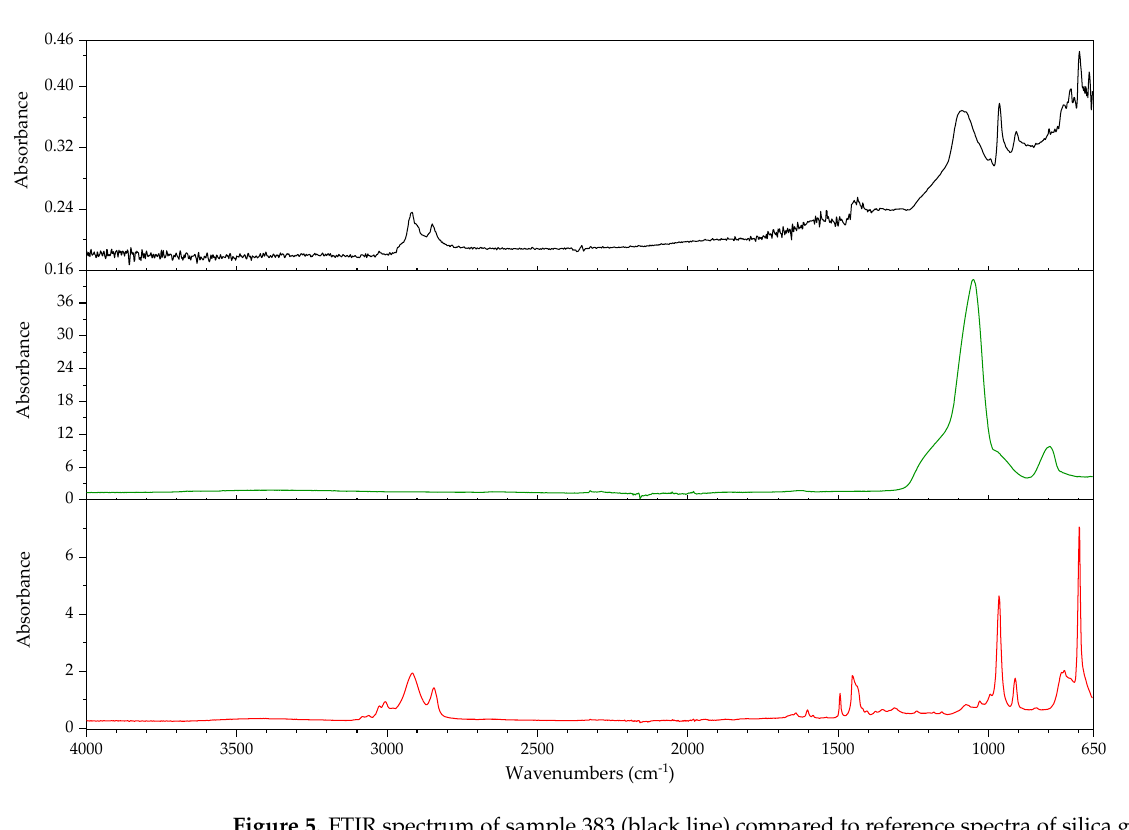
Figure 5. FTIR spectrum of sample 383 (black line) compared to reference spectra of silica gel (green line) and styrene/butadiene block copolymer (red line) from a commercial database.